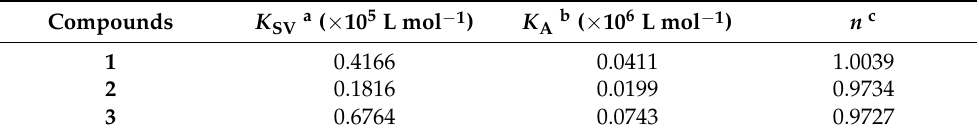
Table 2. Evaluation of Stern–Volmer constants regarding fluorescence quenching effects of HNE inhibitors 1 – 3